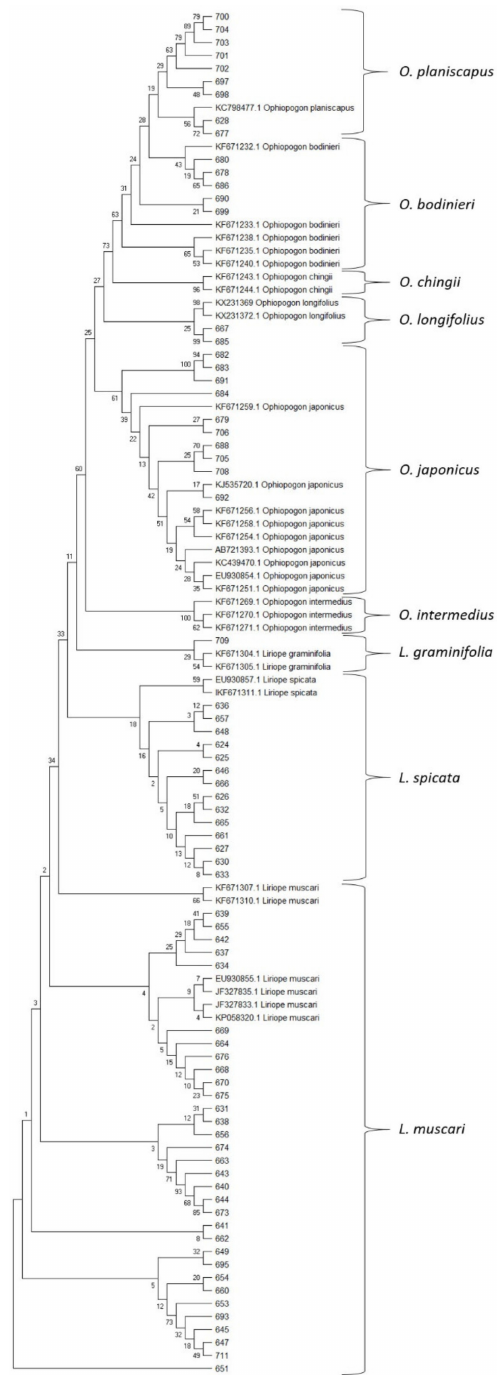
Figure 3. Molecular phylogenetic analysis by the Maximum Likelihood method based on ITS sequences. Ancestral states were inferred using the Maximum Likelihood method [29] and Kimura 2-parameter model [30]. The bootstrap consensus tree inferred from 1000 replicates is taken to represent the evolutionary history of the taxa analysed. Branches corresponding to partitions reproduced in less than 50% bootstrap replicates are collapsed. The percentages of replicate trees in which the associated taxa clustered together in the bootstrap test (1000 replicates) are shown next to the branches. Evolutionary analyses were conducted in MEGA X [31]. The numbers represent the BTG_ sample numbers (Table